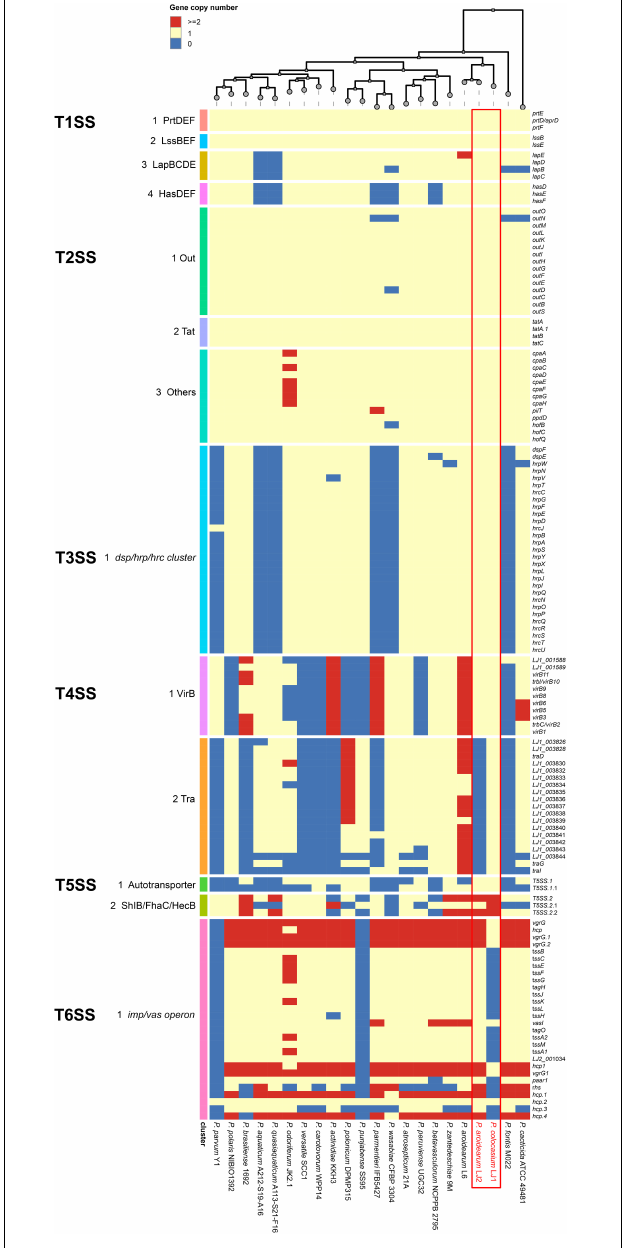
FIGURE 4 | Copy numbers of genes encoding T1SS–T6SS in the genomes of Pectobacterium colocasium sp. nov. LJ1, Pectobacterium aroidearum LJ2, and 20 representative Pectobacterium strains. In the heatmap, each row represents a gene and each column represents a strain. The colors of blue, yellow, and red correspond to gene copy numbers of 0, 1, and 2 or more, respectively.